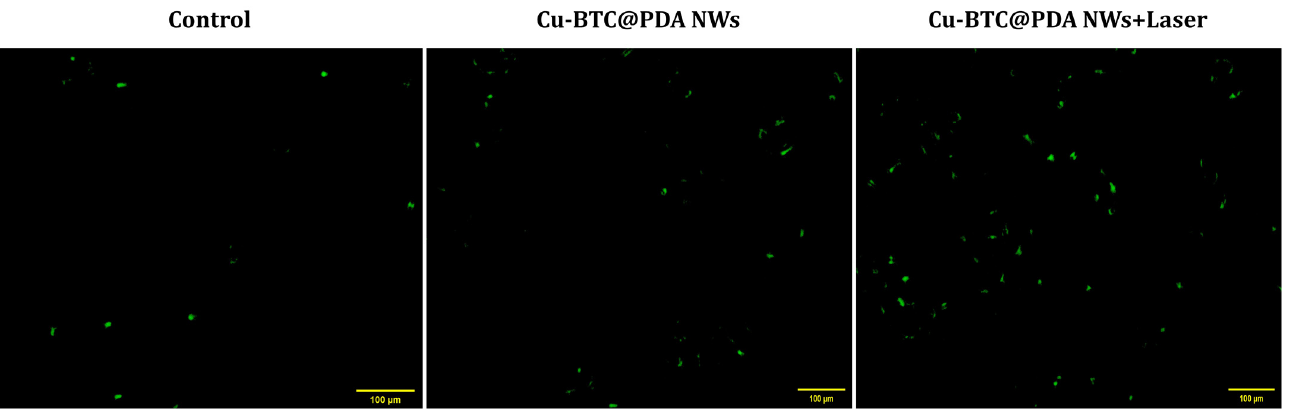
Figure 7. Fluorescence images of DCFH-DA-stained HepG2 cells treated with Cu-BTC@PDA NWs before and after laser (1 W/cm 2 ) irradiation (scale bar: 100 µm). Green color indicates intracellular ROS.